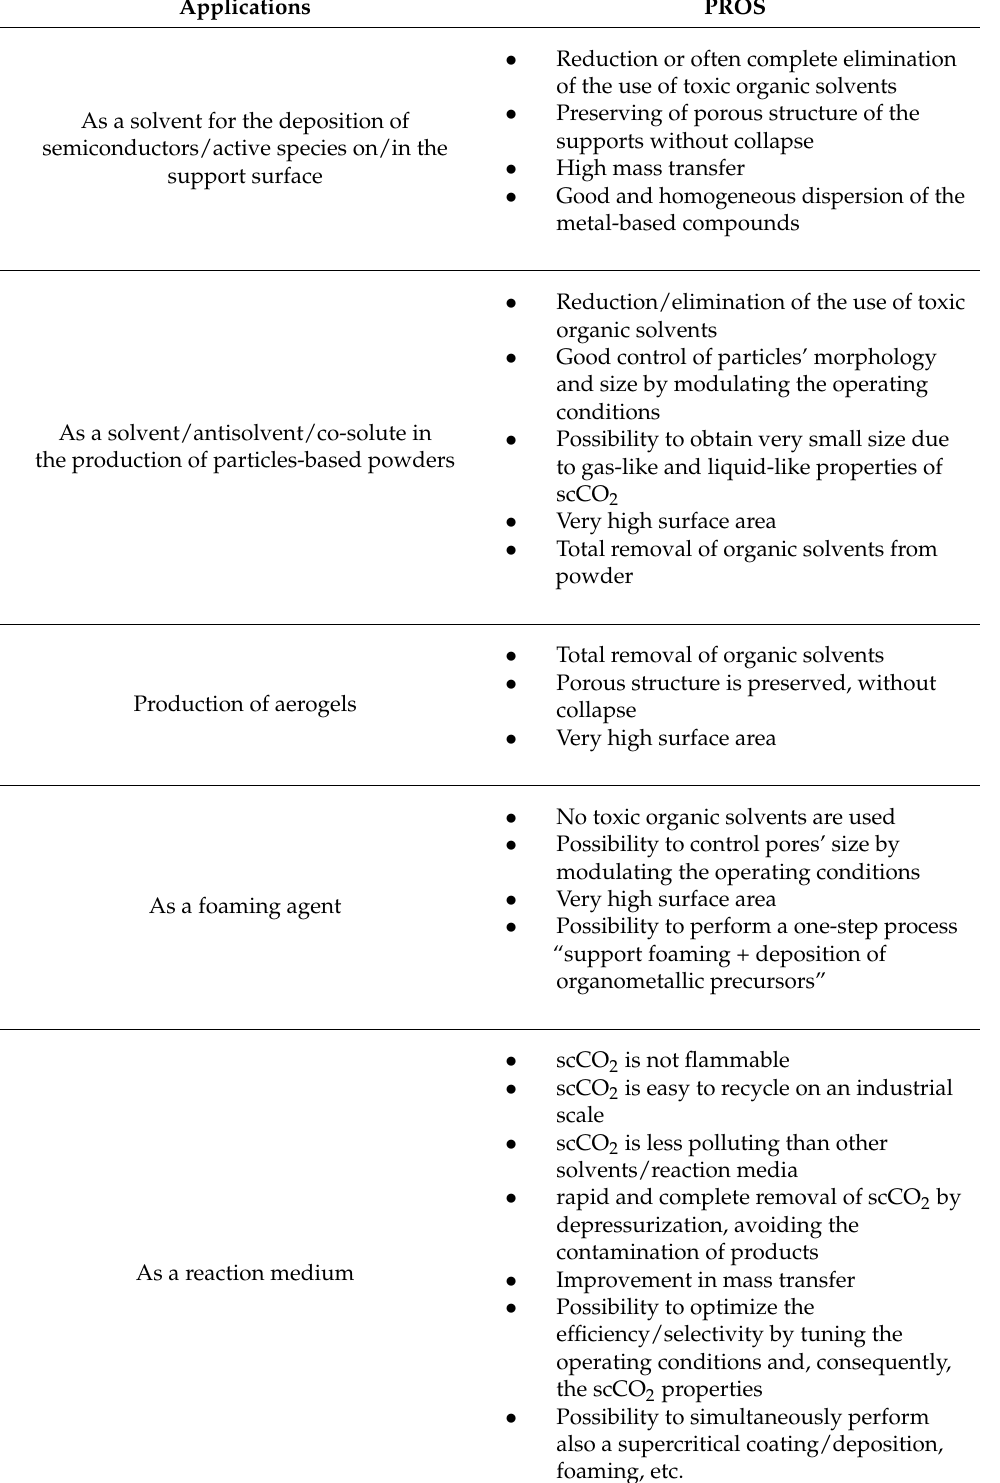
Table 5. A summary about the applications and the advantages of using scCO 2 in